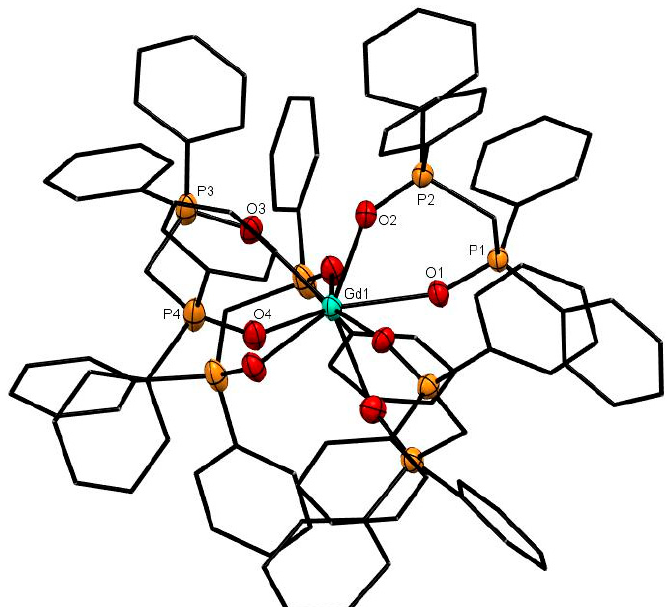
Figure 3. The cation in [Gd(dppmO 2 ) 4 ]Cl 3 . The chloride anions and solvate molecules are omitted. Selected bond lengths (Å): Gd1–O1 = 2.420(2), Gd1–O2 = 2.409(3), Gd1–O3 = 2.415(2), Gd1–O4 = 2.398(2), P1–O1 = 1.504(2), P2–O2 = 1.501(3), P3–O3 = 1.501(3), P4–O4 = 1.501(3). Chelate angle O-Sm-O = 73.1° (av).